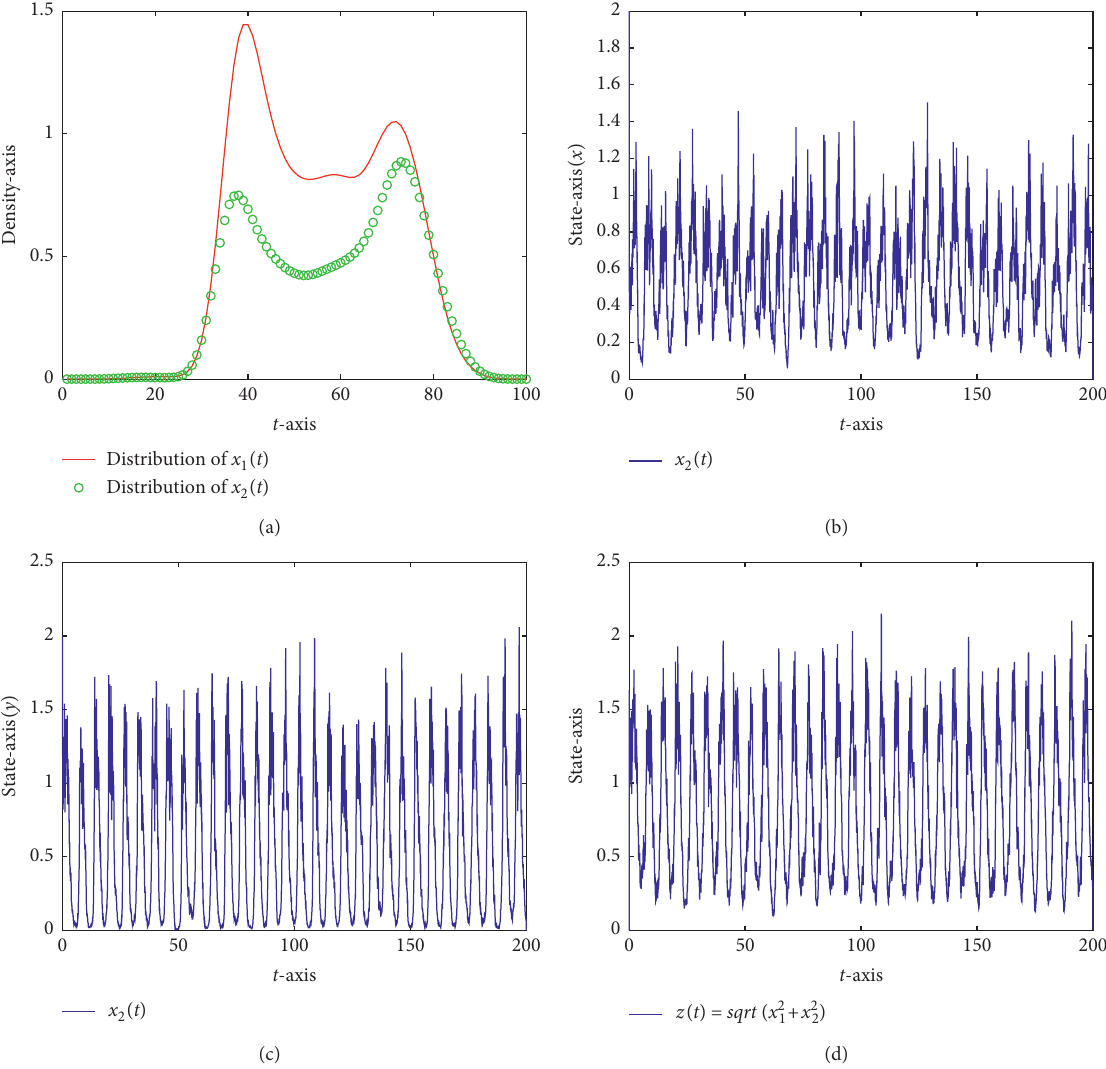
Figure 4: The distribution and stochastic persistence for x ( t ) and x ( t ) , (b) the time series graph of x x 1 2 ( t ) + x 2 ( t )) 1/2 z ( t ) � ( x 2 1 2